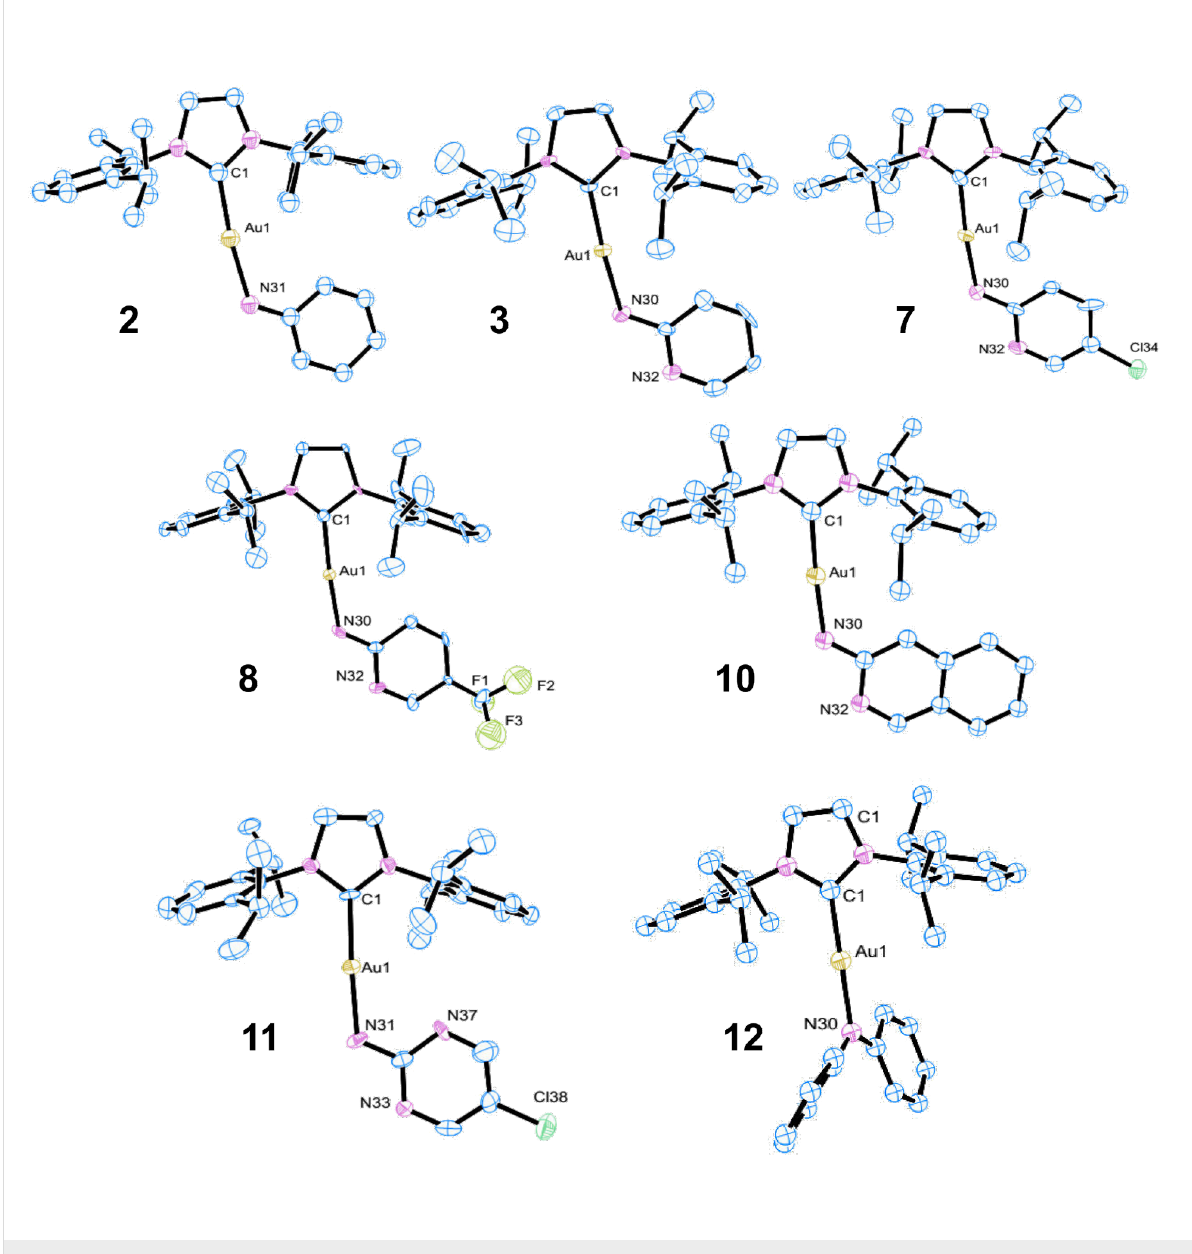
Figure 1: X-ray crystal structures of complexes 2 , 3 , 7 , 8 , 10 , 11 and 12 . Hydrogen atoms are omitted for clarity.